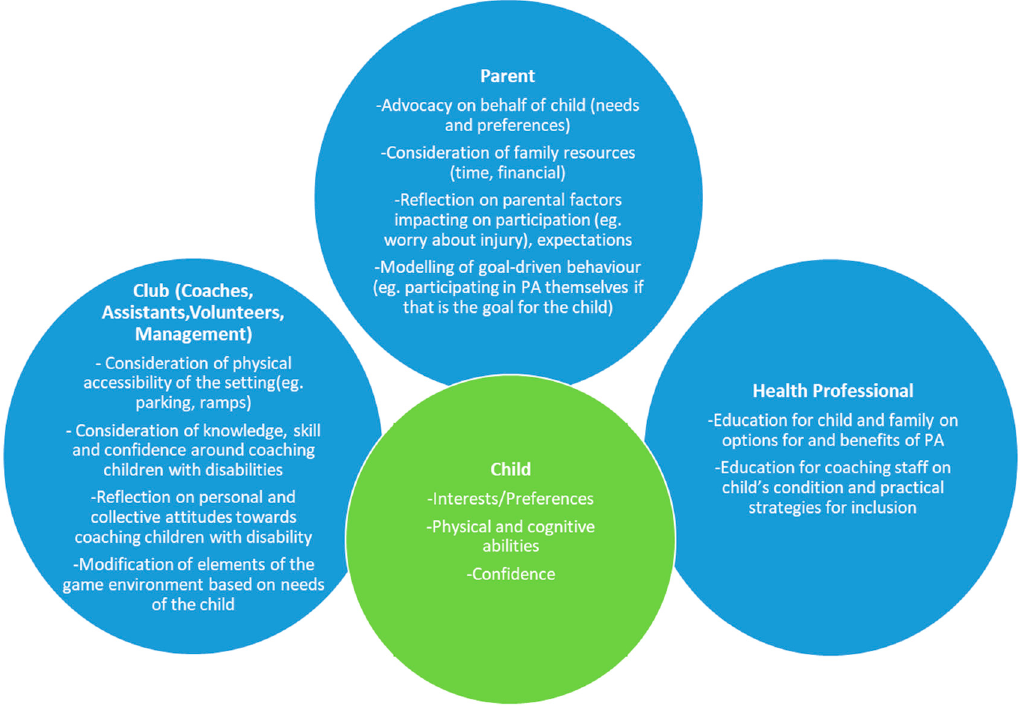
Figure 2. Proposed roles of parents, clinicians and the sporting club in facilitating community-based PA participation.